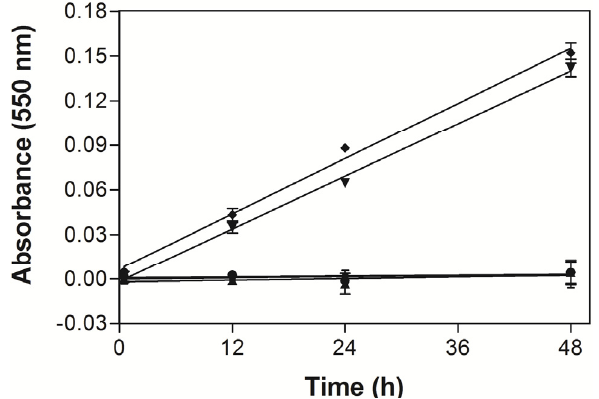
Figure 9. Peroxidase-like activity of ● FeCl represent the standard error of the mean (±SEM) of triplicate